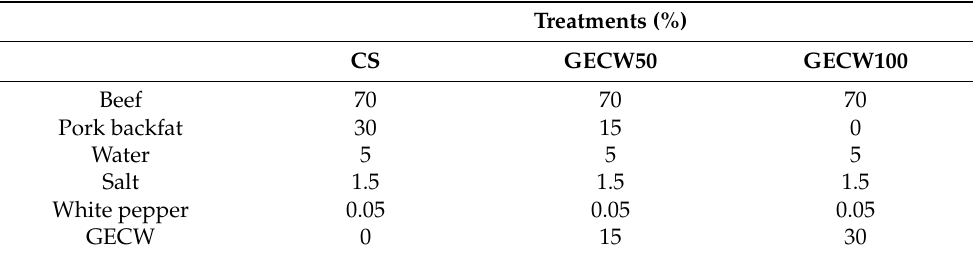
Table 1. Formulation of beef burgers with cocoa bean shell flour and walnut oil emulsion gel used as partial (50%) and total pork backfat